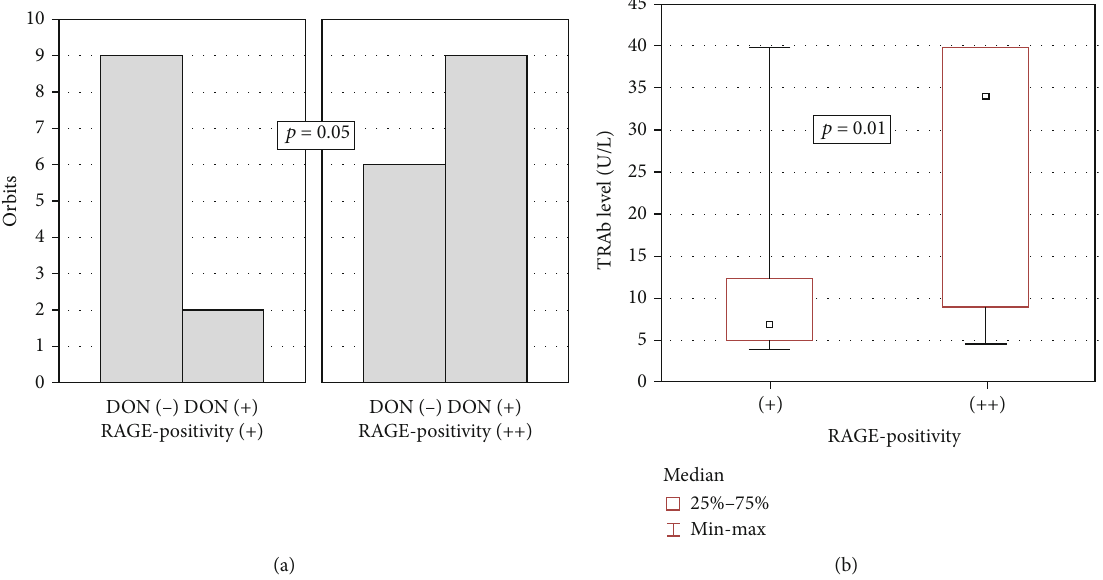
Figure 2: RAGE expression in correlation with clinical data. (a) RAGE positivity vs. occurrence of dysthyroid optic neuropathy (DON) ( p = 0 : 05 ). (b) RAGE positivity vs. levels of TSHR antibodies (TRAb; p = 0 : 01 ). p value ≤ 0.05 was considered to be signi fi cant.